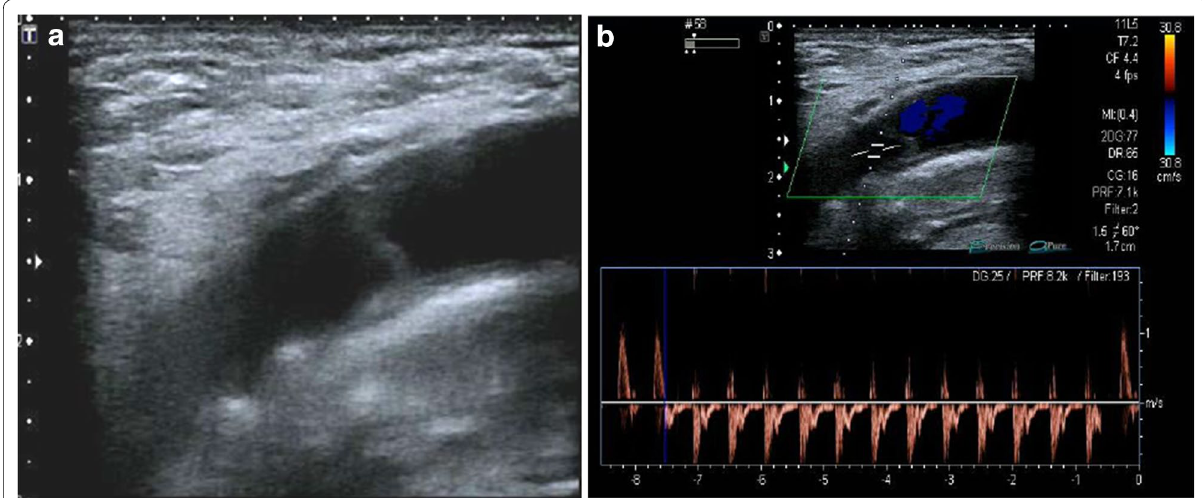
Fig. 11 Post traumatic femoral artery intimal flap. a B mode. Small echogenic flap into the lumen. b Turbulent flow with change of direction of the flow was seen moving the sample volume near the moving flap